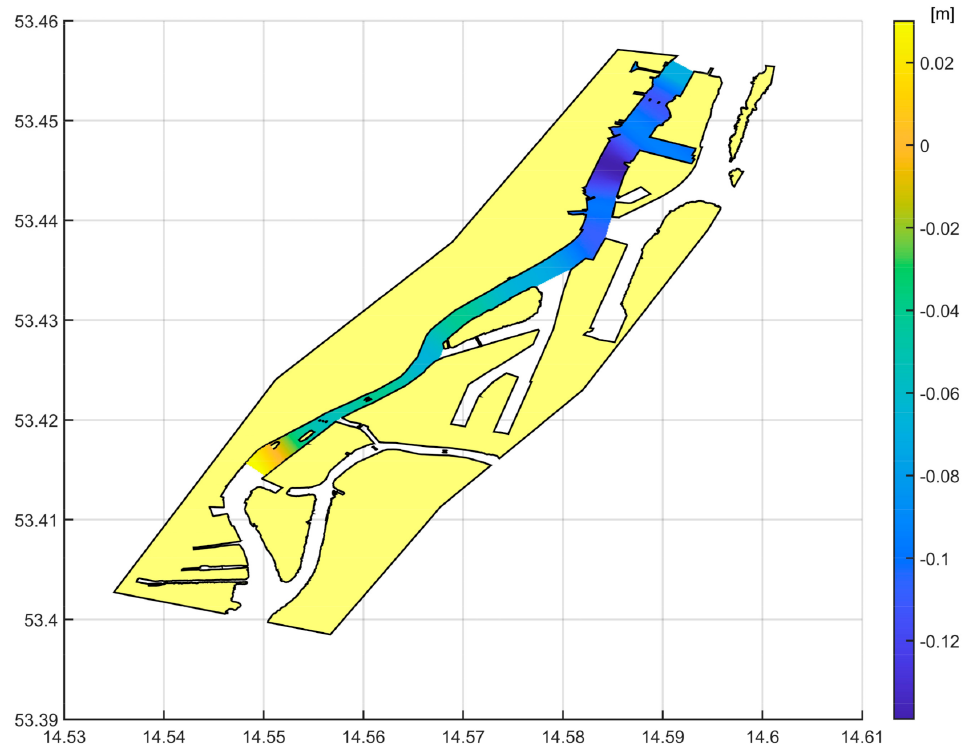
Figure 15. The distribution of dynamic height on the